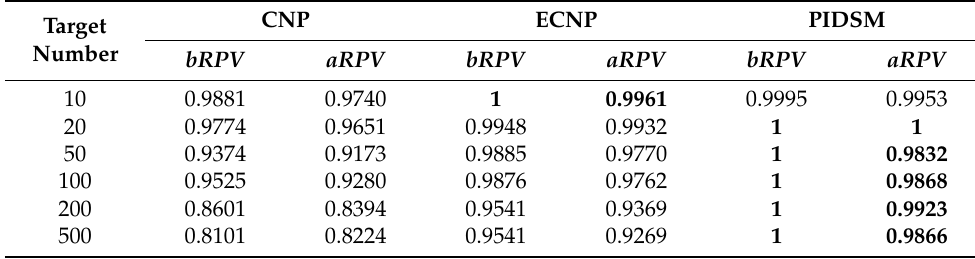
Table 8. Comparison results of different target numbers.